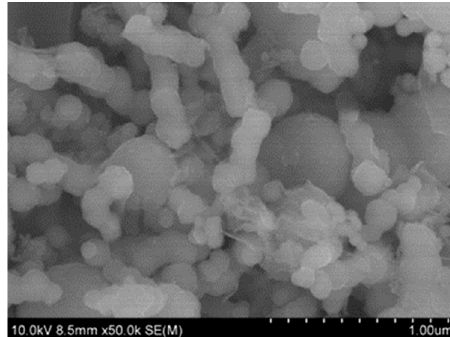
Figure 1. SEM of Co-nZVI/GAC.